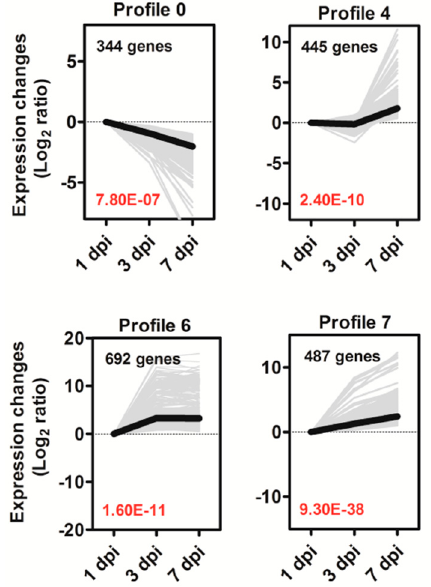
Figure 5. Expression profiles of DEGs in the four main clusters. The top left-hand corner indicates the number of DEGs belonging to the profile. The lower left-hand corner contains the p -value of the profile. The gray lines represent the DEGs, and the bold black line represents the expression tendency of all these DEGs. The x -axis represents days after R. solanacearum inoculation (dpi). The Y-axes represents log 2 fold change in gene expression between treatments .